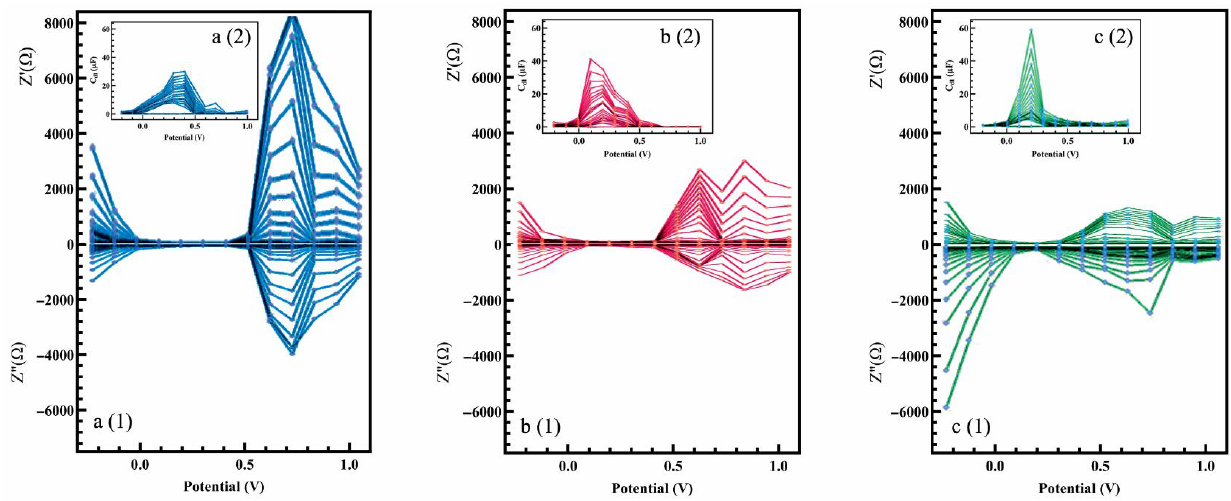
Figure 5. PDEIS spectra (1) impedance and (2) capacitance of electro-synthesized PAni within the potentials of – 0.2 V to 1.0 V for ( a ) Cr (III), ( b ) Cu (II) and ( c ) Fe (III). potentials of –0.2 V to 1.0 V for ( a ) Cr (III), ( b ) Cu (II) and ( c ) Fe